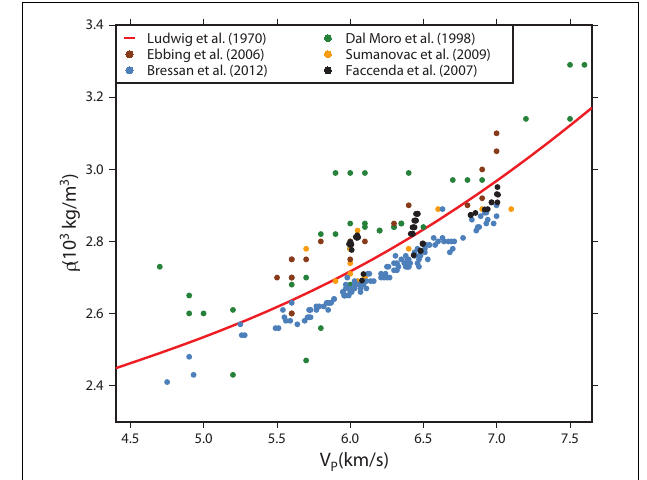
FIGURE 5 | Comparison between the empirical relations of Brocher (2005) between V P and V S and observed V P and V S values. Red line: “Brocher’s regression fit” (BRF); gray line: “mafic line” (ML). Black dots: from the synthetic profiles of Faccenda et al. (2007) (F07); blue dots: from the seismo-gravimetric inversion of Bressan et al. (2012) (B12); green dots: from the tomography of Anselmi et al. (2011) (A11); pink dots: data from the tomography of Viganò et al. (2013) limited to the area to the south of the green line in the map shown in the inset [V13(ML)]; brown dots: data from the tomography of Viganò et al. (2013) limited to the area to the north of the green line [V13(BRF)]; yellow dots: data from the tomography of Viganò et al. (2013), with a depth > 10 km [V13( > 10)]. In the map in the inset, a green line represents the boundary between areas where we applied the different empirical relations (BRF and ML) to convert V P in V S .